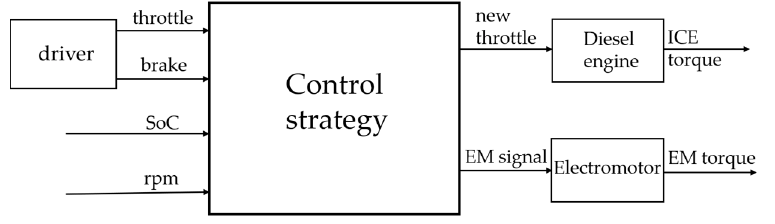
Figure 7. Hybrid control module.